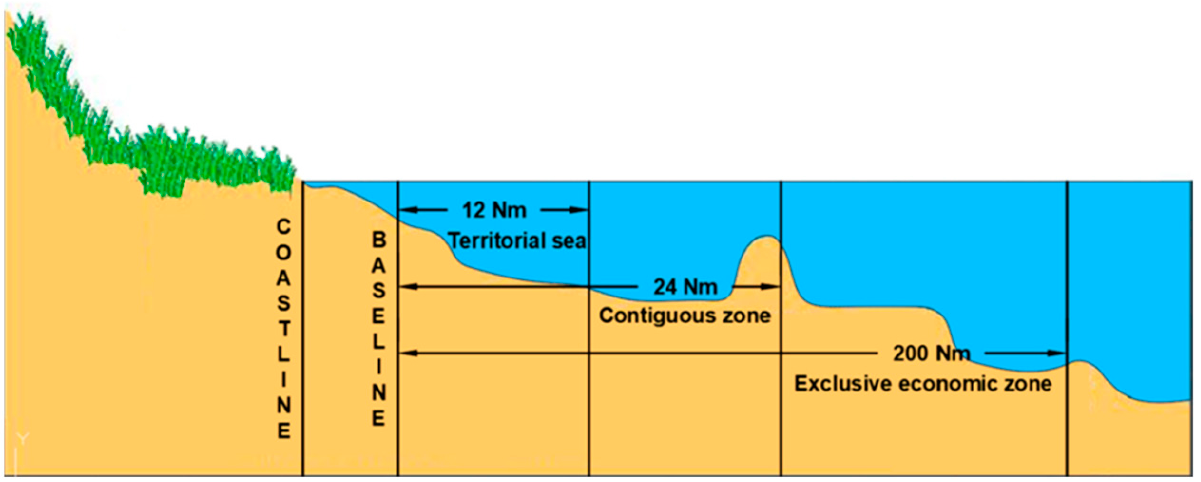
Figure 1. Limits of maritime zones. Own study based on [5].